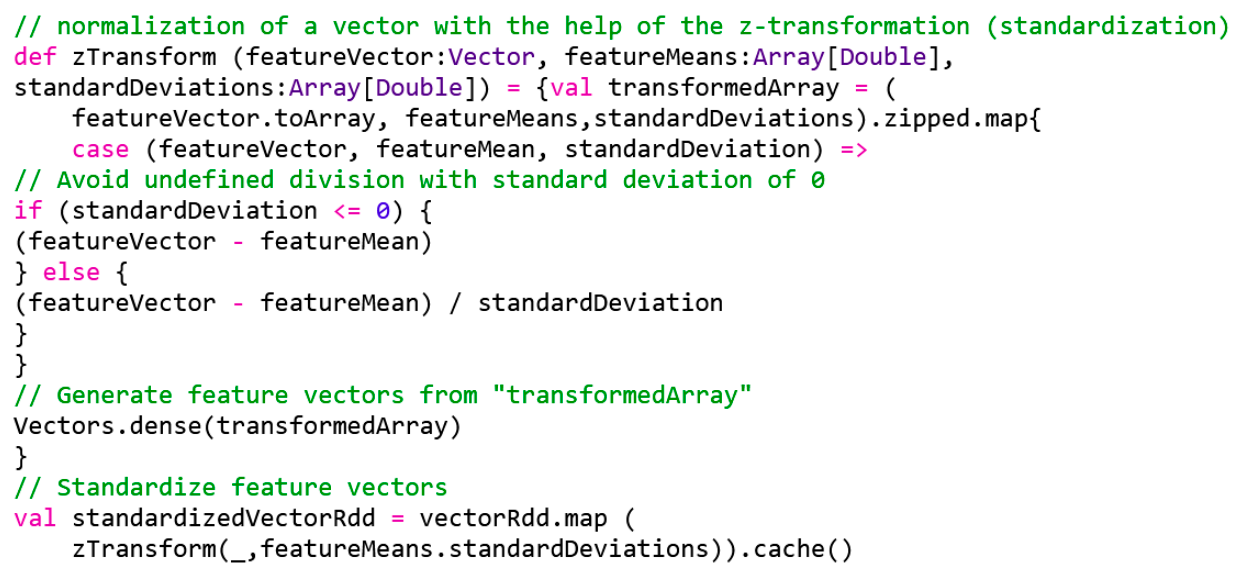
Figure 14. Normalization of the feature vectors through standardization.